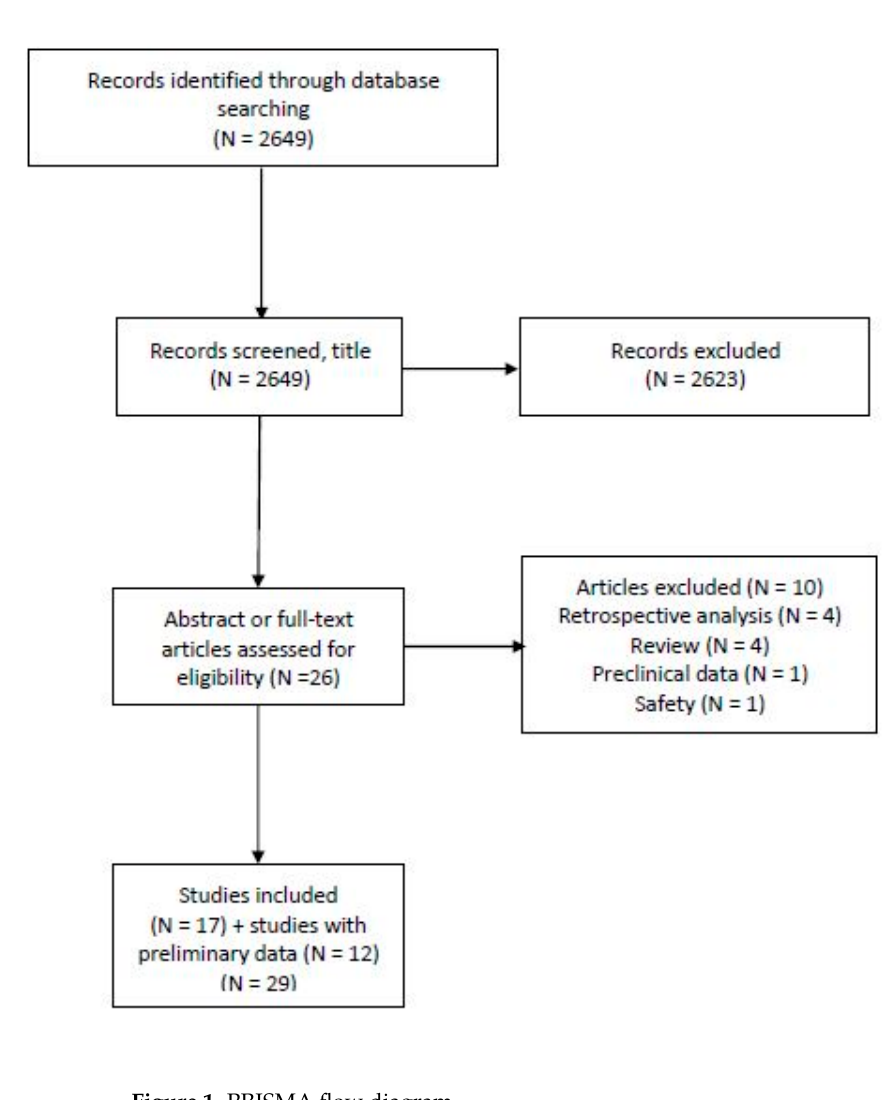
Figure 1. PRISMA flow diagram.